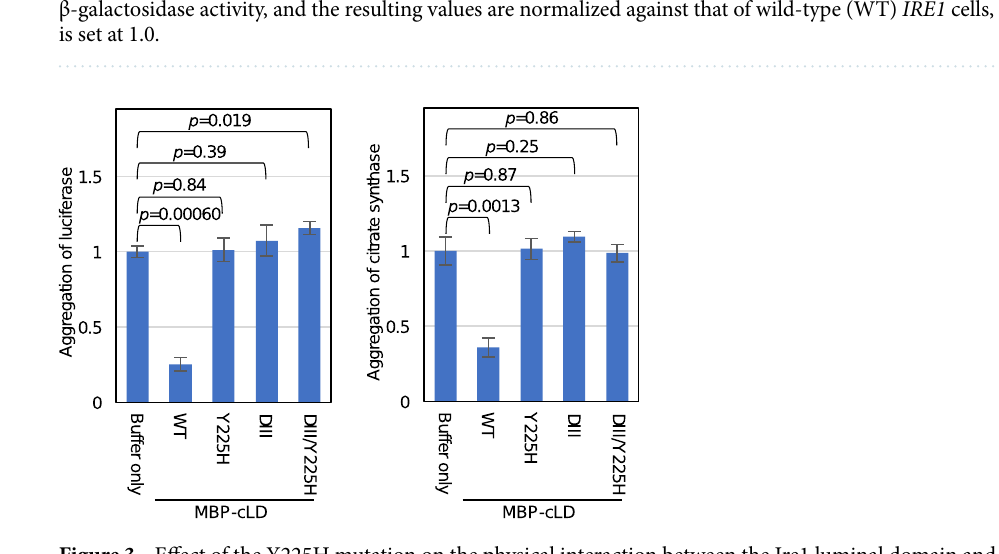
considerably induces HAC1 -mRNA splicing in both ΔIΔV-Ire1 cells and ΔIΔV/Y225H-Ire1 cells. A similar result was obtained when we checked the cellular abundance of KAR2 mRNA (supplementary Fig. S5). As shown in Fig. 4b, ΔIΔV/Y225H Ire1 did not lose responsiveness to tunicamycin even when further mutagenized to carry the ΔIII mutation. Based on our observations presented thus far, we speculate that ΔIΔV/Y225H Ire1 and ΔIΔIIIΔV/Y225H Ire1 are regulated by none of the previously known regulatory events on the luminal side. We then explored the molecular basis underlying the responsiveness of ΔIΔIIIΔV/Y225H Ire1 to ER stress.